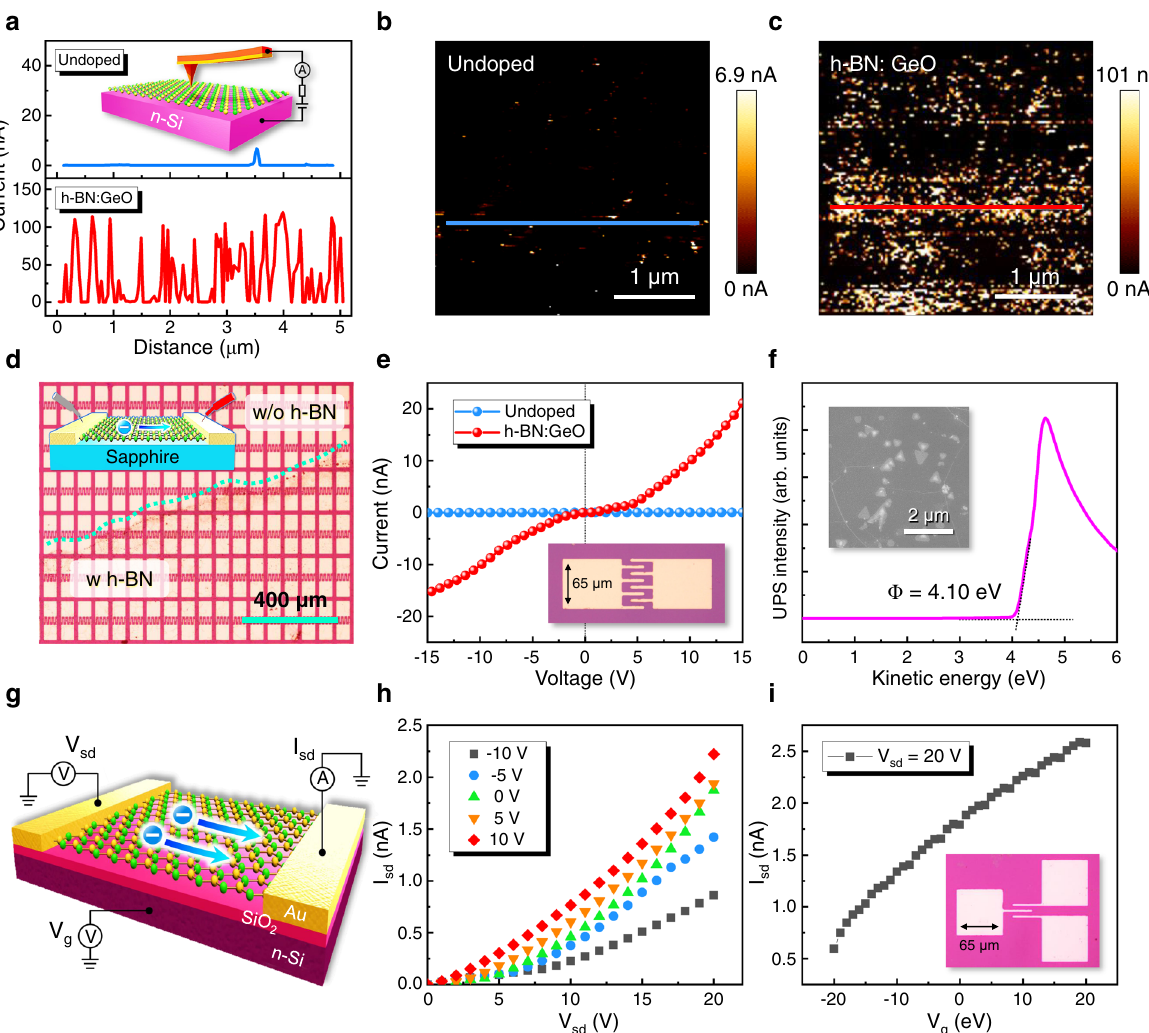
Fig. 4 Electrical properties of the h-BN:Ge-O monolayer. a Current line scan of CAFM test for undoped h-BN and h-BN:Ge-O, respectively. The inset shows the setup of the CAFM. b – c The current mapping of CAFM test for the undoped h-BN and h-BN:Ge-O, respectively. d Optical image of h-BN monolayer transferred on sapphire substrate with Au electrode array. e I – V curve of the h-BN:Ge-O monolayer compared with the undoped h-BN. f UPS spectrum of the h-BN:Ge-O monolayer in the kinetic energy scale. Work function is determined by the intersection-point method. g Schematic of the FET devise using h-BN:Ge-O monolayer as n -type channel. h – i Output characteristics and transfer curve of the h-BN:Ge-O monolayer based FET